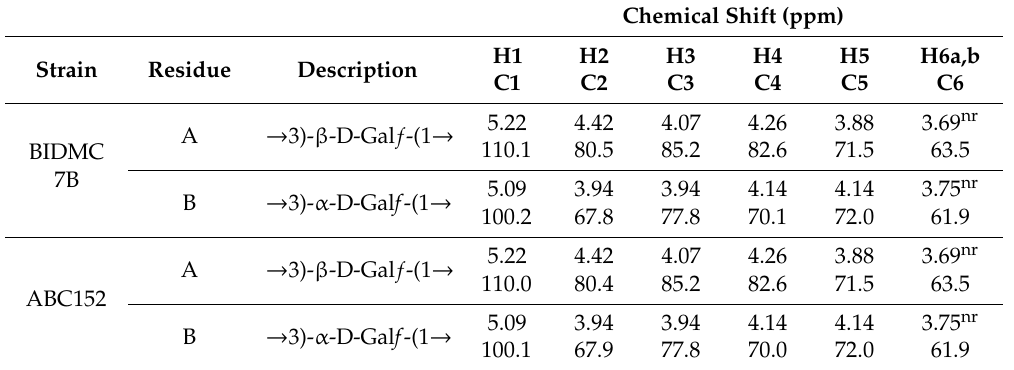
Table 1. 1 H and 13 C NMR chemical shifts of O-specific polysaccharides from K. pneumoniae BIDMC 7B and ABC152